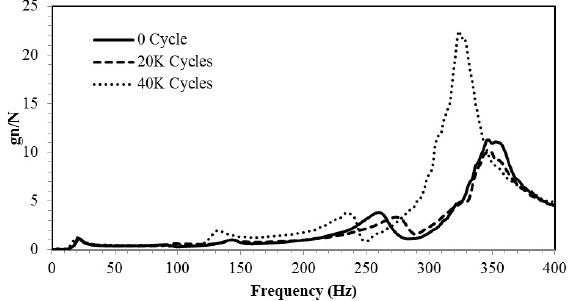
Fig. 10. Comparison of FRF Plots of H1 Beam after 20 000 cycles and 40 000 Cycles.